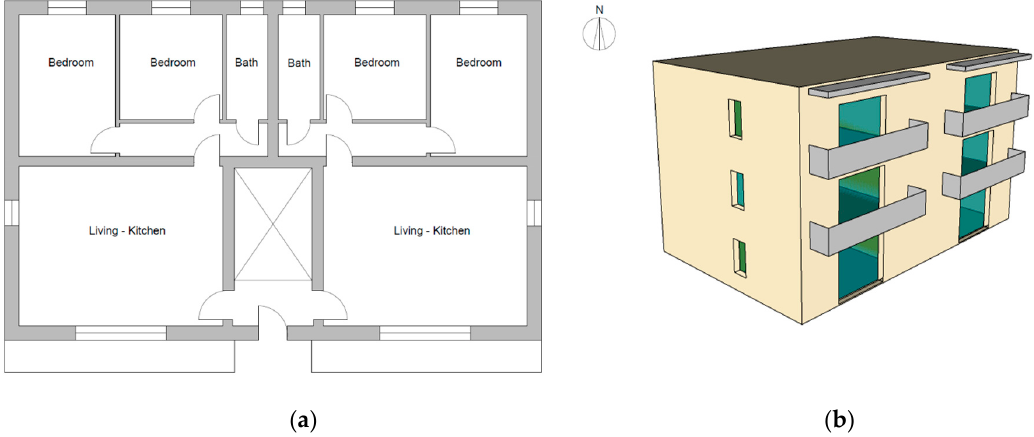
Figure 2. ( a ) Analyzed building: building plan (1:200) and ( b ) southwest view. Table 1. Geometrical features of the apartment.